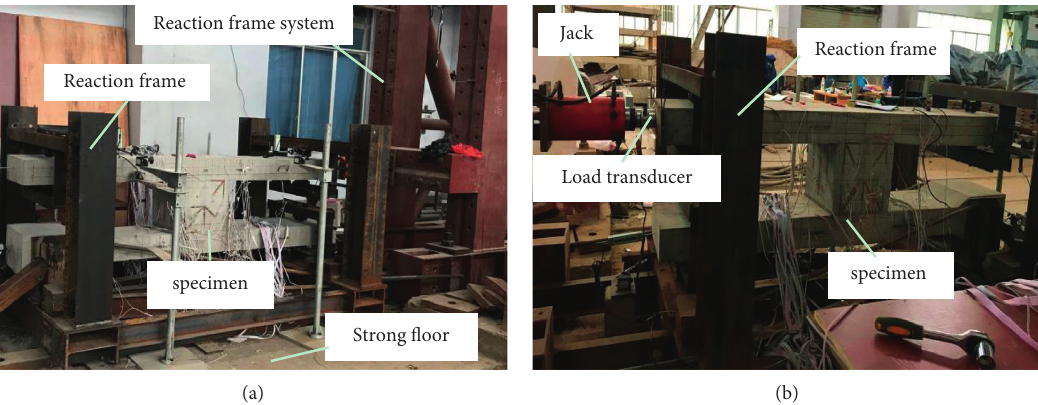
Figure 7: Test loading device diagram. (a) Back side of the test loading device. (b) Front side of the test loading the existing cracks on the upper surface of the right- hand top chord further develop and run through the chord width, and new cracks also occurred at the same time; the lower surface of right-hand bottom chord has 3 cracks that run through the chord width and extend to the side of the chord.